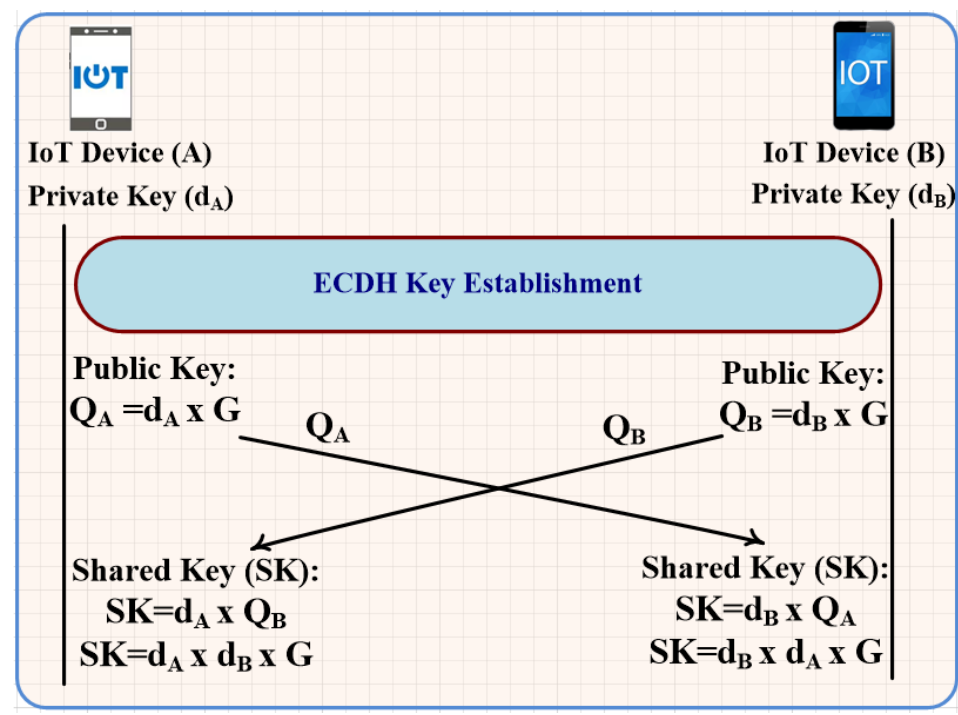
Figure 2. The ECDH key establishment process.